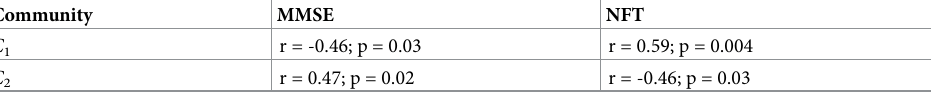
Table 1. Results of correlation test between the first principal component of C 1 and C 2 communities and clinical features. The results show significant correlation ( p - value < 0.05) of both gene communities with MMSE and